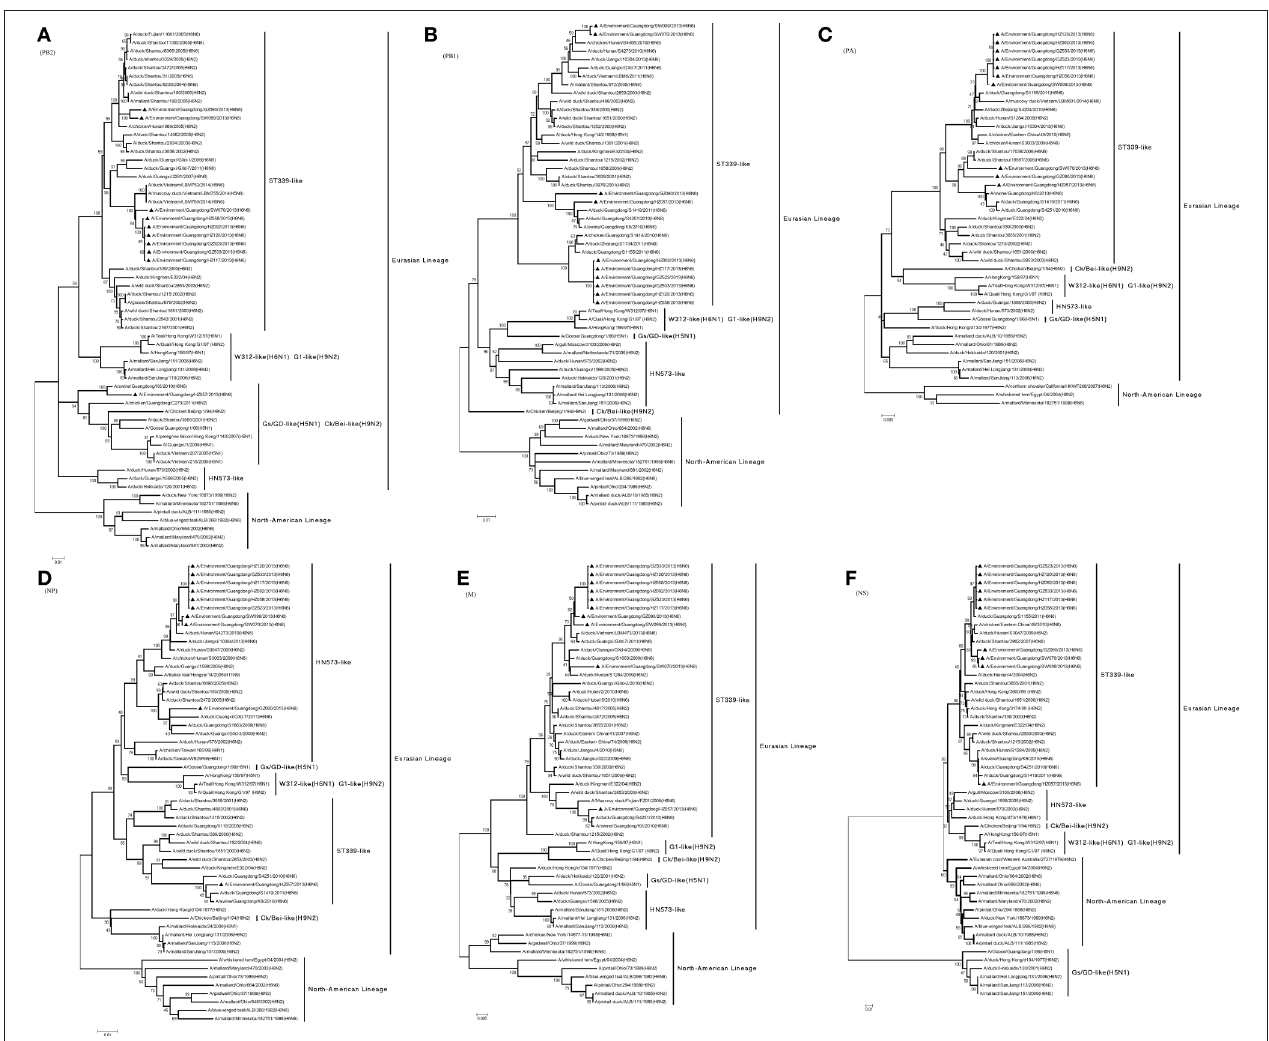
FIGURE 3 | Phylogenetic trees of the open reading frames of six internal genes of subtype H6N6 influenza A viruses isolated in Guangdong: (A) PB2, (B) PB1, (C) PA, (D) NP, (E) M, and (F) NS. Viruses indicated with black triangles ( N ) were characterized in this study. The trees were constructed using the neighbor-joining method of MEGA 6.06, with 1000 bootstrap trials to assign confidence to the